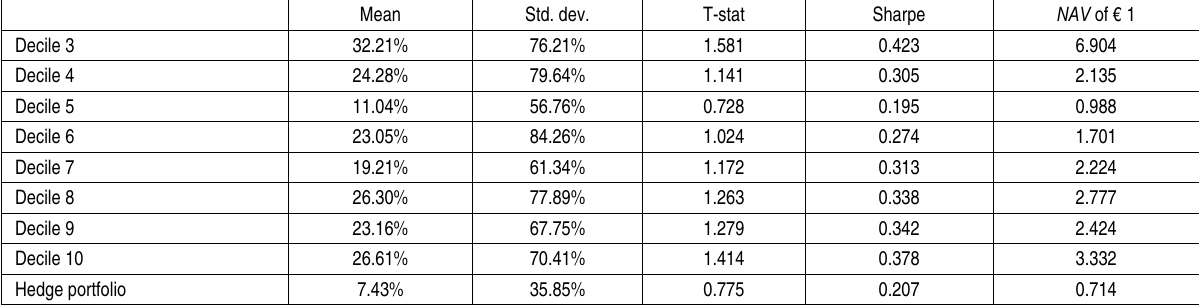
Table 2a (cont.). Performance statistics on accrual portfolios of traditional accruals